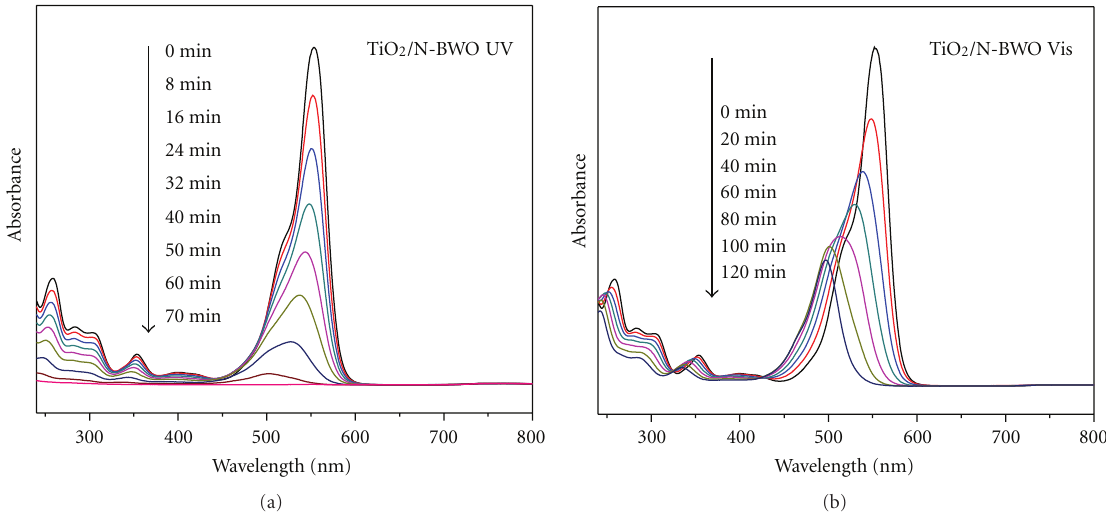
Figure 9: Temporal evolution of the spectral changes during the photodegradation of RhB over TiO 2 /N-BWO under ultraviolet light irradiation (a) and visible light irradiation